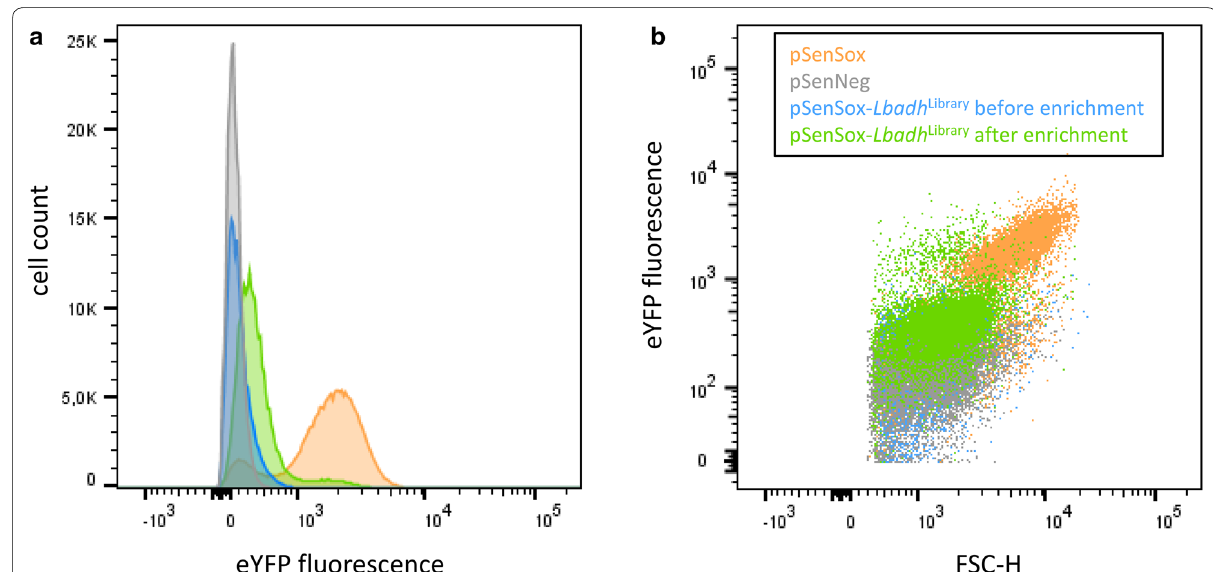
Fig. 1 FACS analysis of the Lb ADH mutant library. Comparison of the fluorescence distribution of the E. coli TOP10/pSenSox- Lbadh Library culture before (blue) and after three positive enrichment steps followed by one negative and another positive enrichment step (green). E. coli TOP10/ pSenSox cells (orange) were used as positive control and E. coli TOP10/pSenNeg cells (gray) as negative control. Before FACS analysis, cells of the different cultures were incubated for 2.5 h with the substrate 2,5-hexanedione. Prior to sorting, 2.5 10 5 cells of each culture were analyzed. The × plots were generated with the BD DIVA 6.1.3 software. a Histogram of the four E. coli cultures described above. b Dot plots of the four cultures described above displaying the eYFP fluorescence signal against the forward scatter height (FSC-H) reflecting the size of the